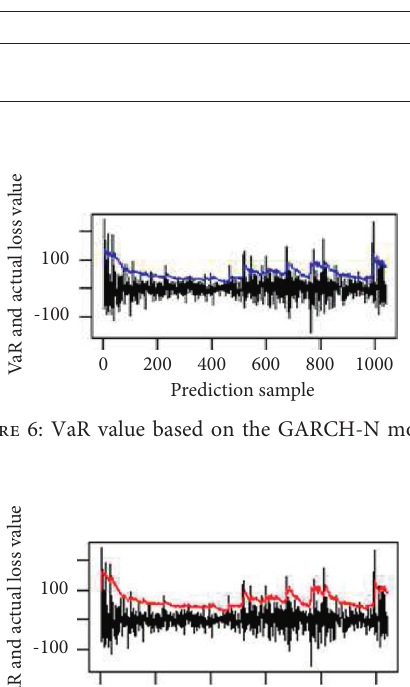
Figure 5: Residual error graph. Table 4: ARCH effect test results.